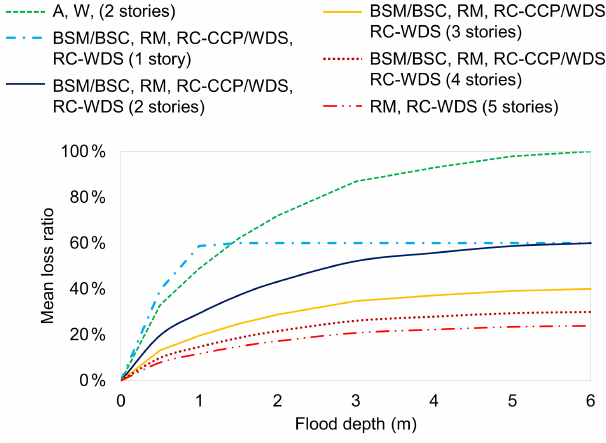
Figure 5. Flood vulnerability functions for the different considered building typologies and their associated range of